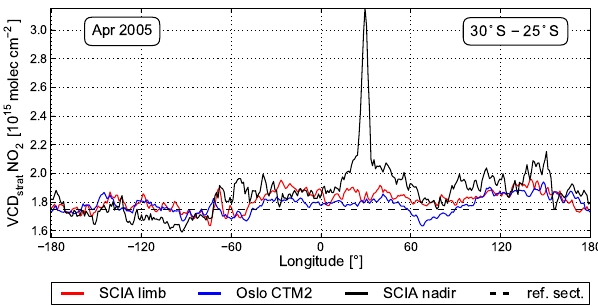
ref. sect. Fig. 13. Zonal variation of VCD 0 limb strat , VCD 0 mod strat , and VCD 0 nadir strat . The nadir measurements’ value over the reference sector is marked asdashedblackline. MonthlymeanvaluesforApril2005,between30 ◦ and25 ◦ S. higher than the limb measurements at many other longitudes. This might be a hint leading to issues 420 inthenadirretrievalovercleanoceanwaters,forexamplefromliquidwaterabsorptionorvibrational Ramanscatteringinwater(Vountasetal.,2003;Lerotetal.,2010). Amoresystematicinvestigation of this is needed, but outside the scope of this study.